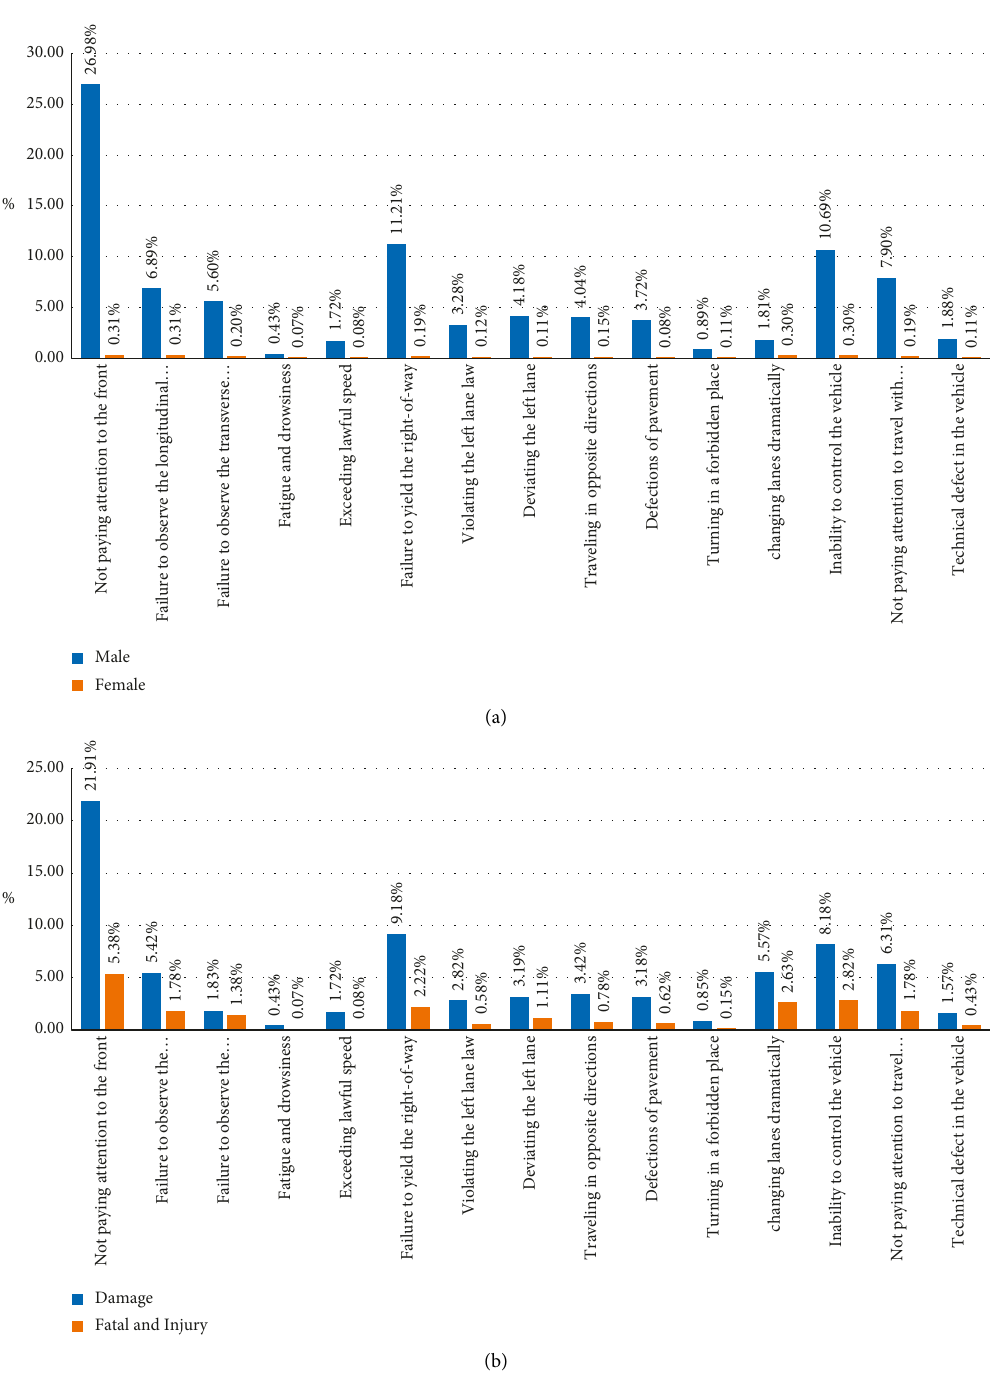
Figure 5: Statistics of vehicle accidents based on the reason of accident: (a) gender of the driver and (b) severity of